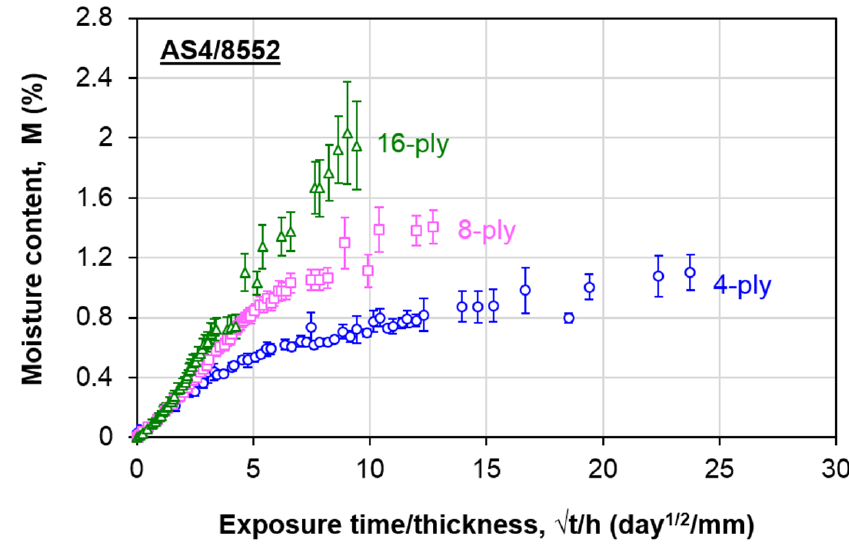
Figure 3. Water absorption behavior of AS4/8552 carbon/epoxy composite laminates.